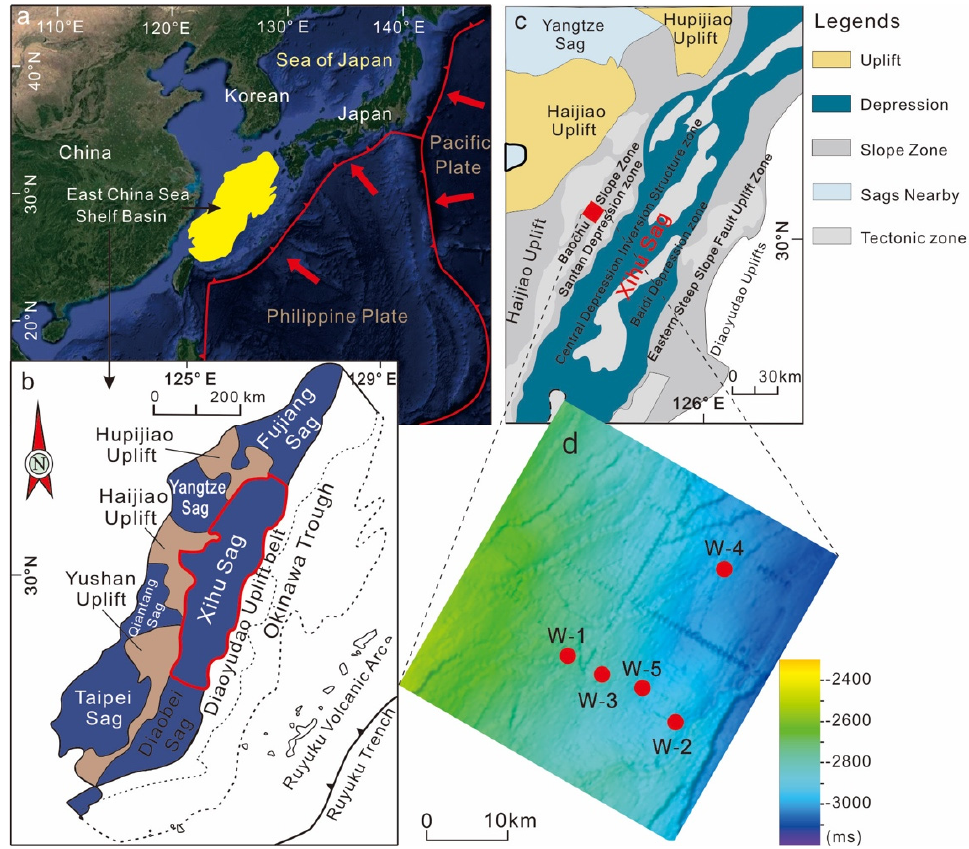
Figure 1. ( a ) Location of the study area; ( b ) tectonic units in the East China Sea Shelf Basin; ( c ) tectonic units of the Xihu sag; and ( d ) A block and the location of the study cores. Developed from [37,40].